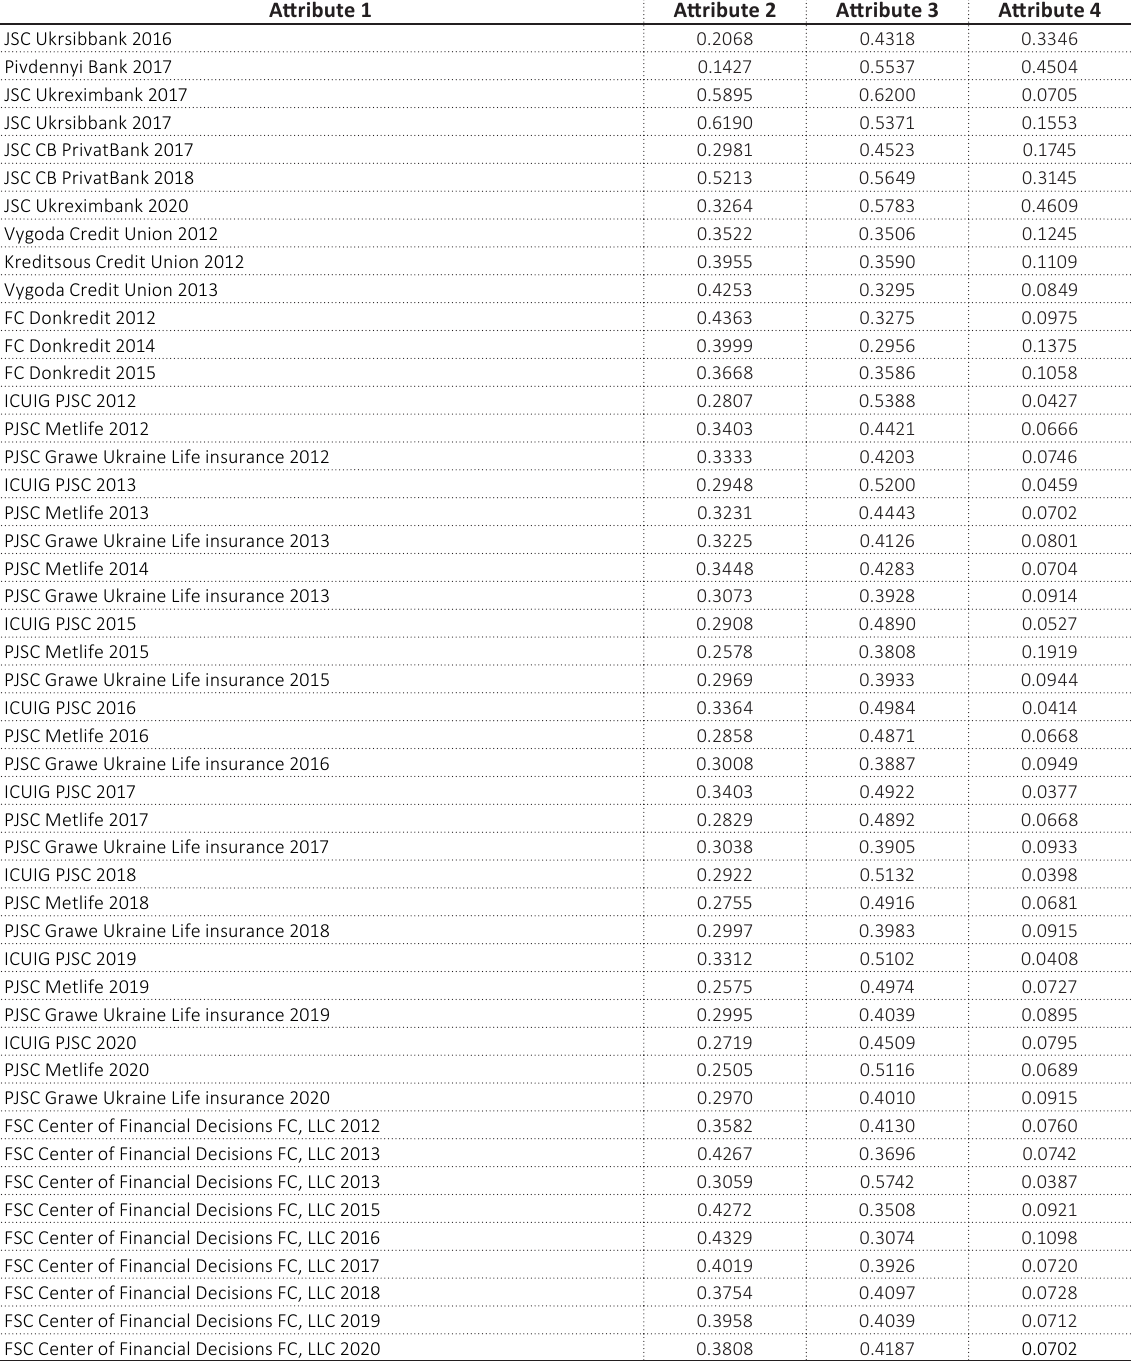
Table 6. Financial intermediaries included in pattern C1